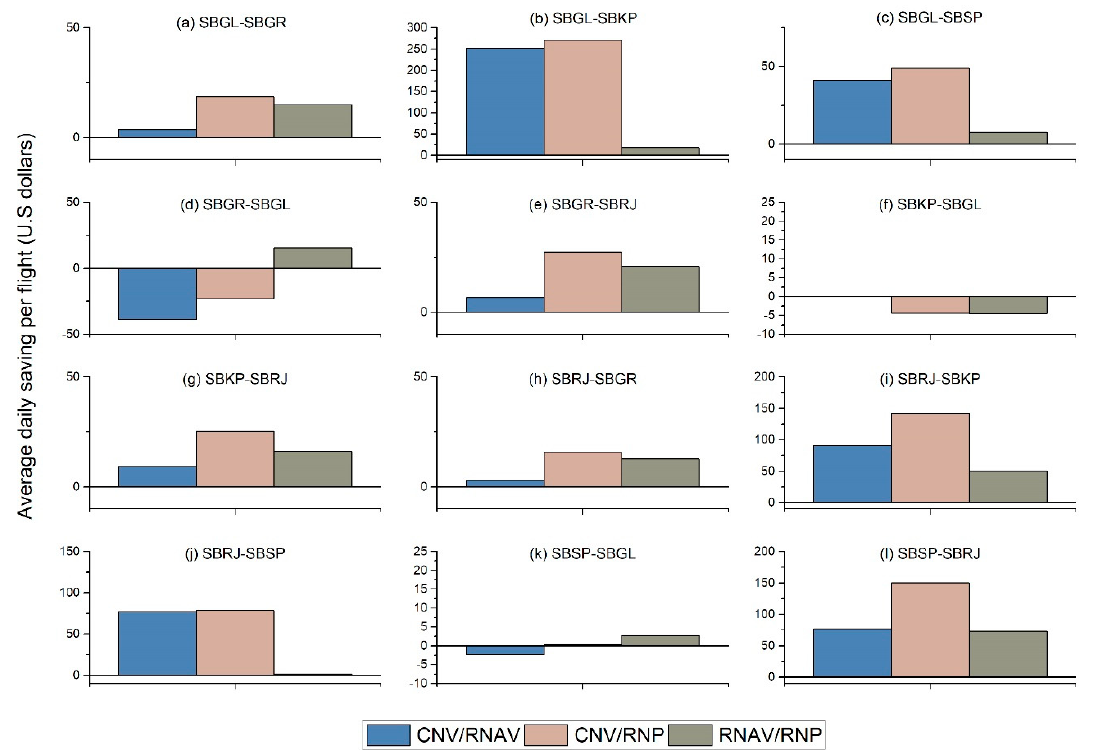
Figure 10. Average daily savings in dollars by route. ( a ) SBGL-SBGR; ( b ) SBGL-SBKP; ( c ) SBGL-SBSP; ( d ) SBGR-SBGL; ( e ) SBGR-SBRJ; ( f ) SBKP-SBGL; ( g ) SBKP-SBRJ; ( h ) SBRJ-SBGR; ( i ) SBRJ-SBKP; ( j ) SBRJ-SBSP; ( k ) SBSP-SBGL; ( l ) SBSP-SBRJ.